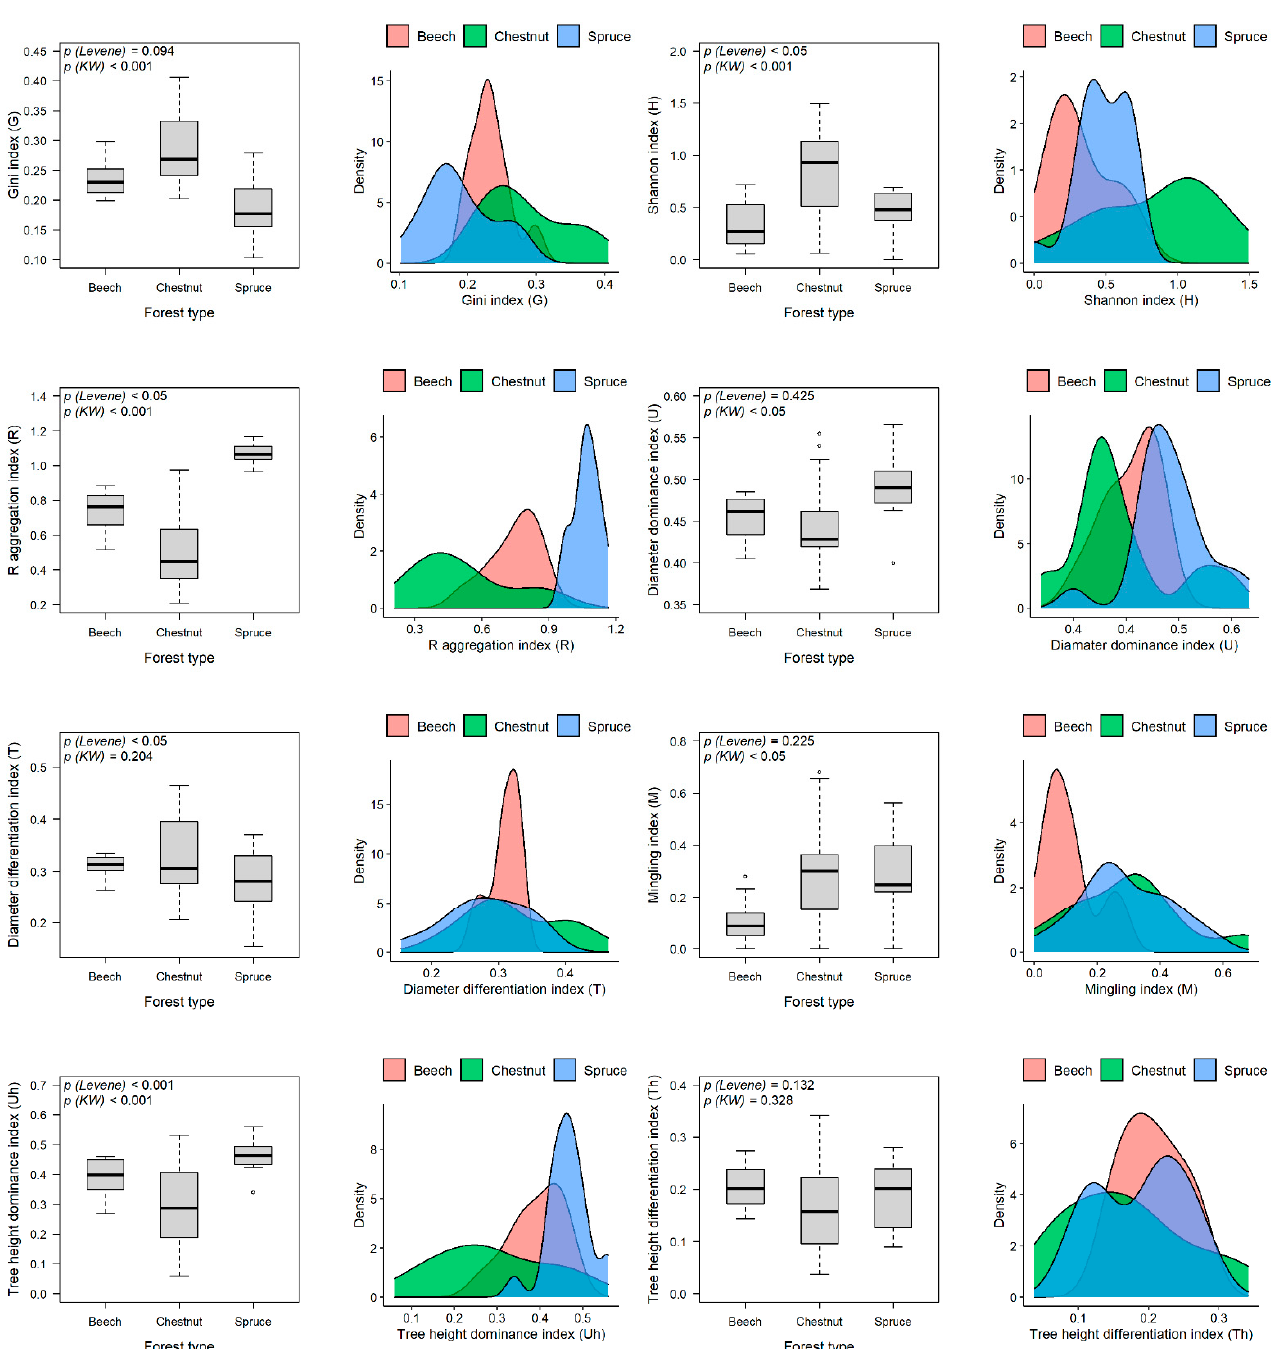
Figure 3. Distributions of the stand structural indices within each forest type (beech = European beech forest, chestnut = sweet chestnut forest, spruce = Norway spruce forest), and the results from the Kruskal–Wallis test (KW) and Levene’s test (Levene). The distribution of the indices is reported in the form of boxplots as well as density diagrams.